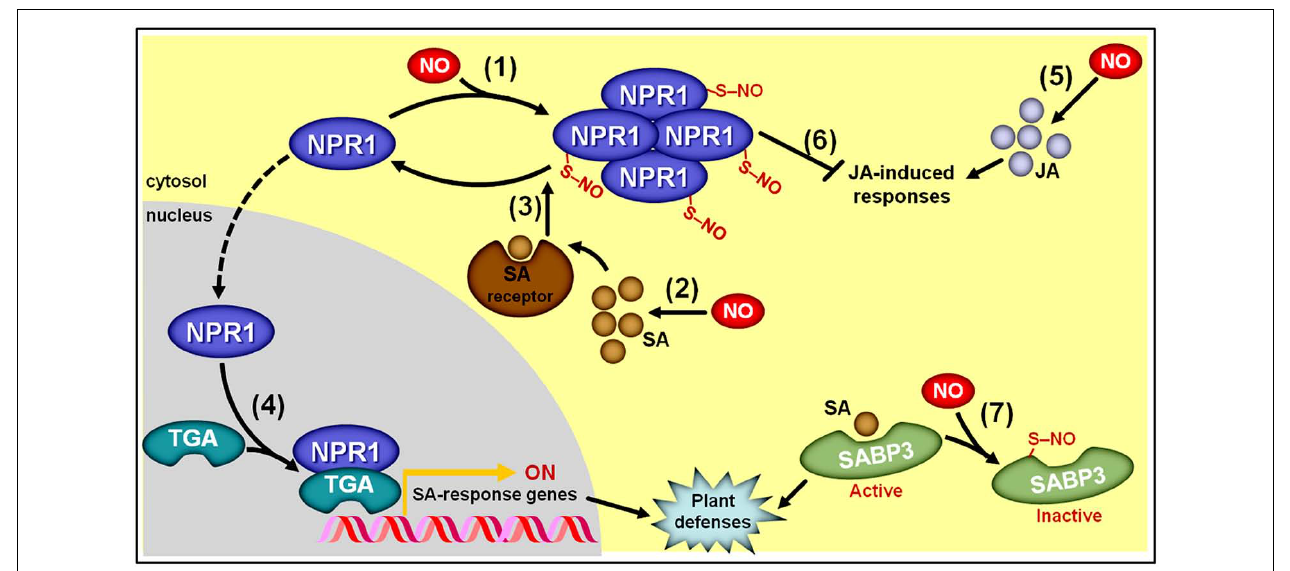
FIGURE 9 | Simplified schematic representation of NO, salicylic acid (SA), and jasmonic acid (JA) interactions during plant responses to biotic challenges. (1) S -nitrosylation of NON-EXPRESSER OF PATHOGENESIS-RELATED GENE1 (NPR1) at cys156 promotes its oligomerization and permanence in the cytosol. (2) NO stimulates SA biosynthesis. (3) Oligomeric NPR1 is denitrosylated following its interaction with SA receptors, which promotes the formation of monomeric NPR1. (4) Monomeric NPR1 translocates to the nucleus,